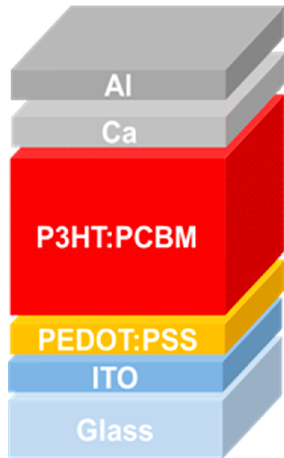
Figure 8. Sketch of the investigated polymer:fullerene solar cells. Sixteen devices have been fabricated and analyzed for each